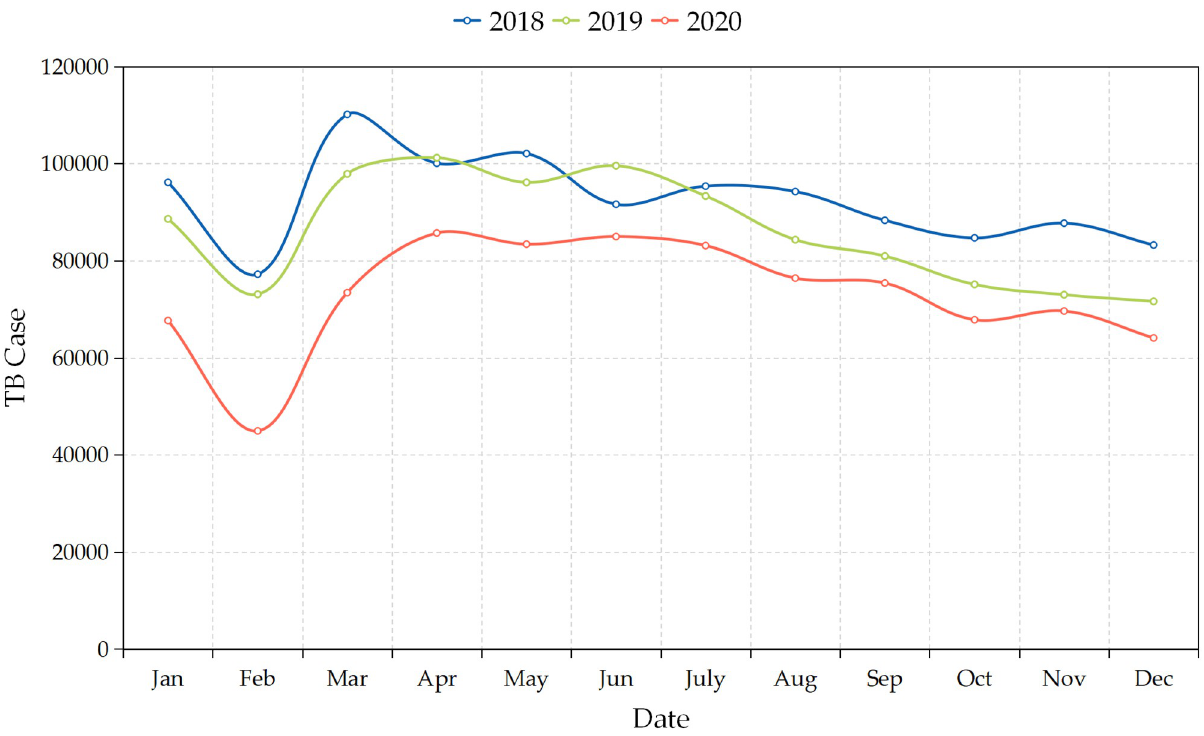
Fig 2. Time series monthly reported cases of TB in mainland China from January 2018 to December 2020.